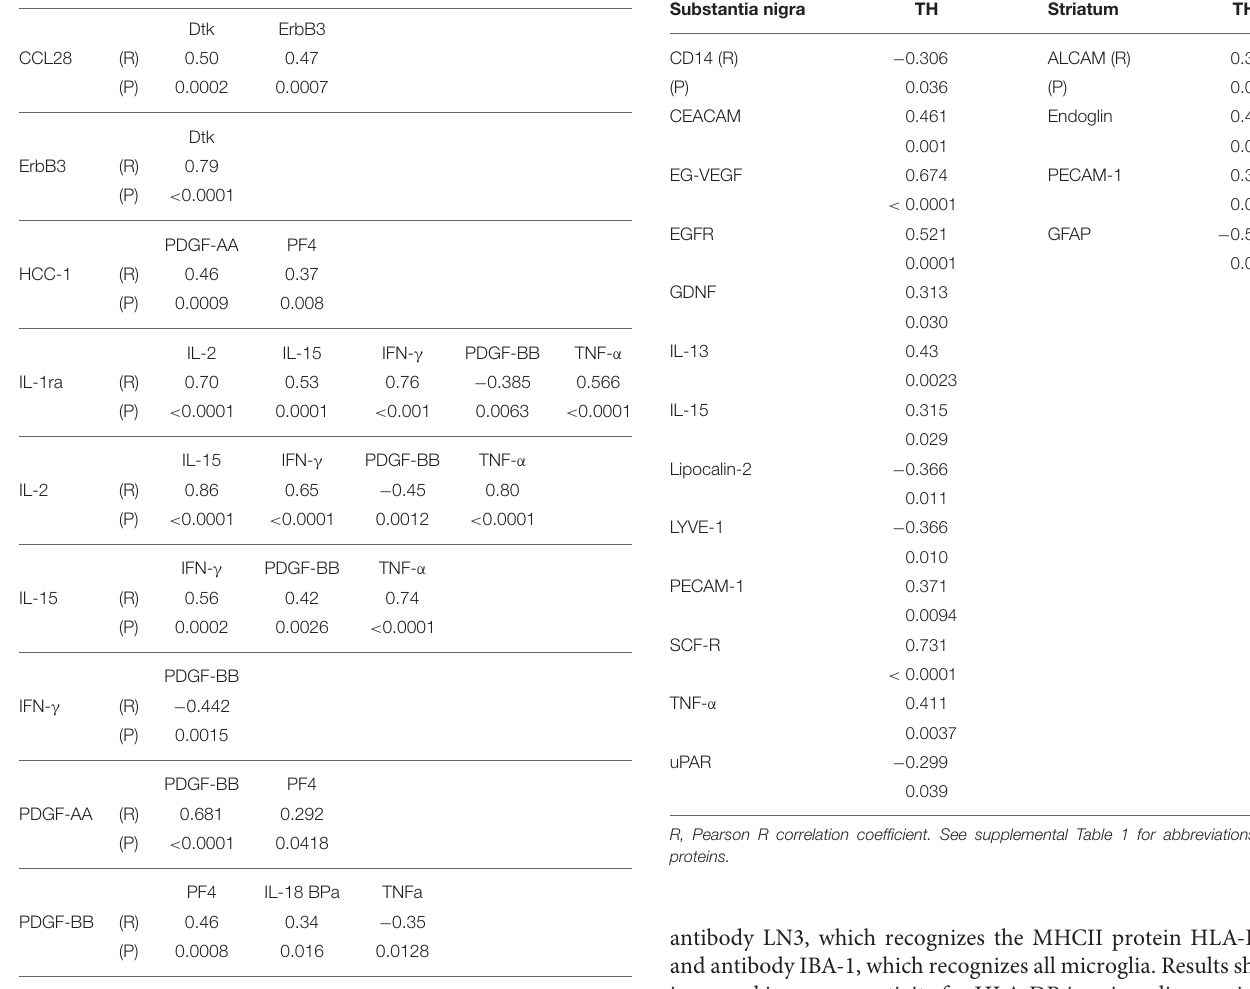
TABLE 6 | Significant Correlation between key protein measures in striatum.